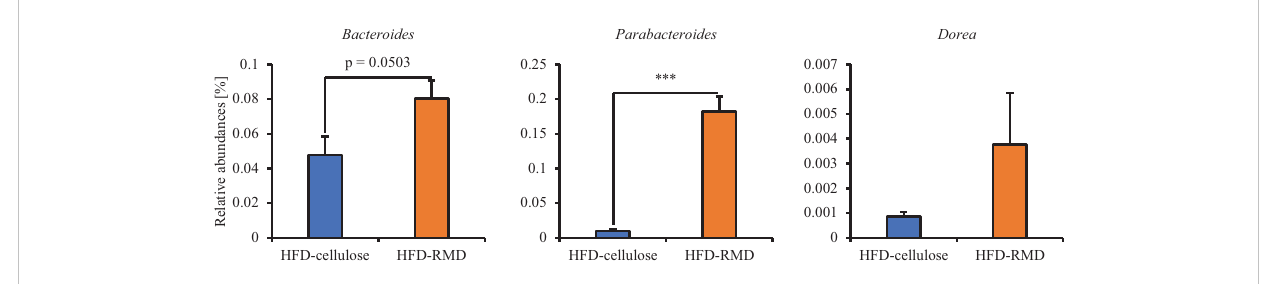
FIGURE 5 Effects of resistant maltodextrin on relative abundance of some bacteria. Relative abundance at All data are shown as means ± SEM (n = 7). *** p < 0.001 (Mann Whitney tests).